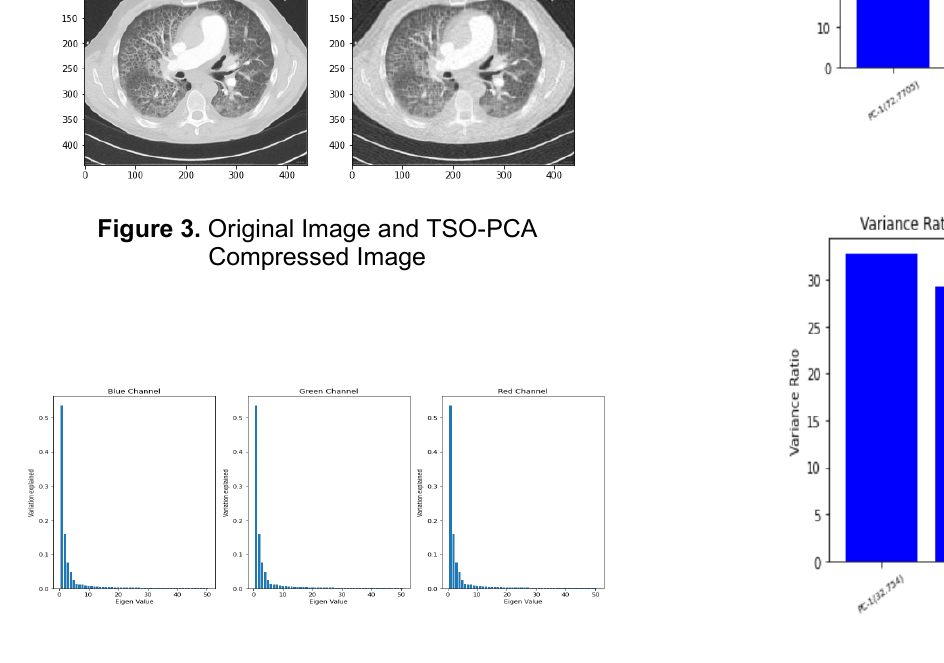
Figure 4. Let’s plot bar charts to check the explained variance ratio by each eigenvalue separately for each of the 3 channels.